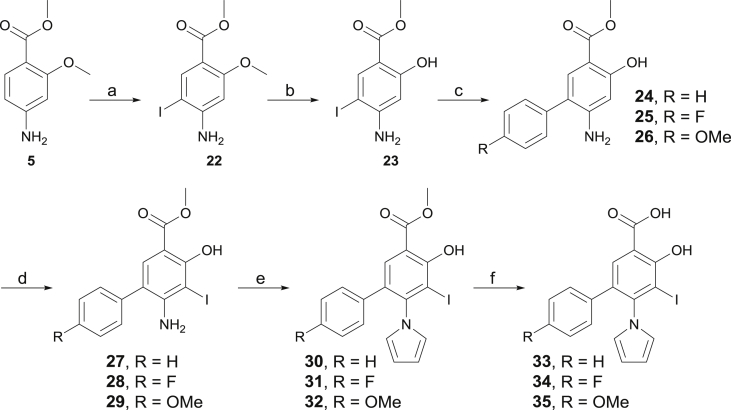
Synthesis of biaryl analogues 33–35 by cross-coupling at C5 for exploration of subsite 2.aaConditions: (a) NIS, MeCN, 0 °C to rt, quant.; (b) BBr3, CH2Cl2, 0 °C, 59%; (c) ArB(OH)2, Pd(PPh3)4, Cs2CO3, dioxane/H2O, 80 °C, 49–80%; (d) NIS, MeCN, 0 °C, 60–90%; (e) 2,5-dimethoxytetrahydrofuran, AcOH, 80 °C, 76–96% (f) NaOH, THF/H2O, rt, quant.